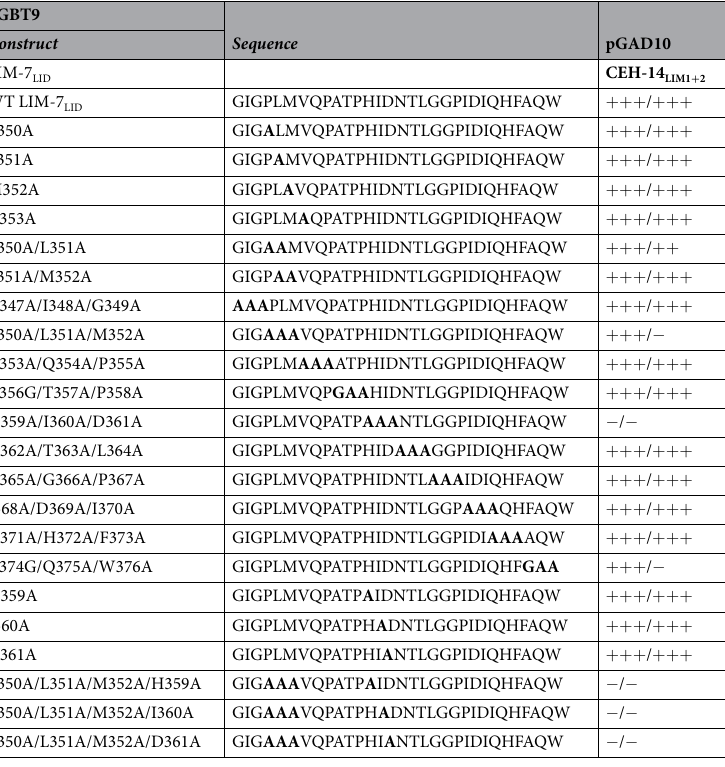
Table 2. Yeast two-hybrid mutagenic screens for CEH-14 and LIM-7 interactions. Y2H assay summary for alanine mutagenic screening of LIM-7 LID against CEH-14 LIM1 + 2 . Results are reported as yeast growth on moderate (SD -H-L-W + 1mM 3-AT )/strong (SD -H-L-W-A ) selective media. Yeast growth is represented as either ‘ +++ ’, ‘ ++ ’ or ‘ + ’ for robust growth at all three dilution points (10°, 10 − 1 , 10 − 2 ), two dilution points (10°, 10 − 1 ) or only on the first dilution point (10 0 ), respectively. ‘ − ’ represents no detectable yeast growth. LIM-7 LID and CEH- 14 LIM1 + 2 constructs were in the vectors pGBT9 and pGAD10,